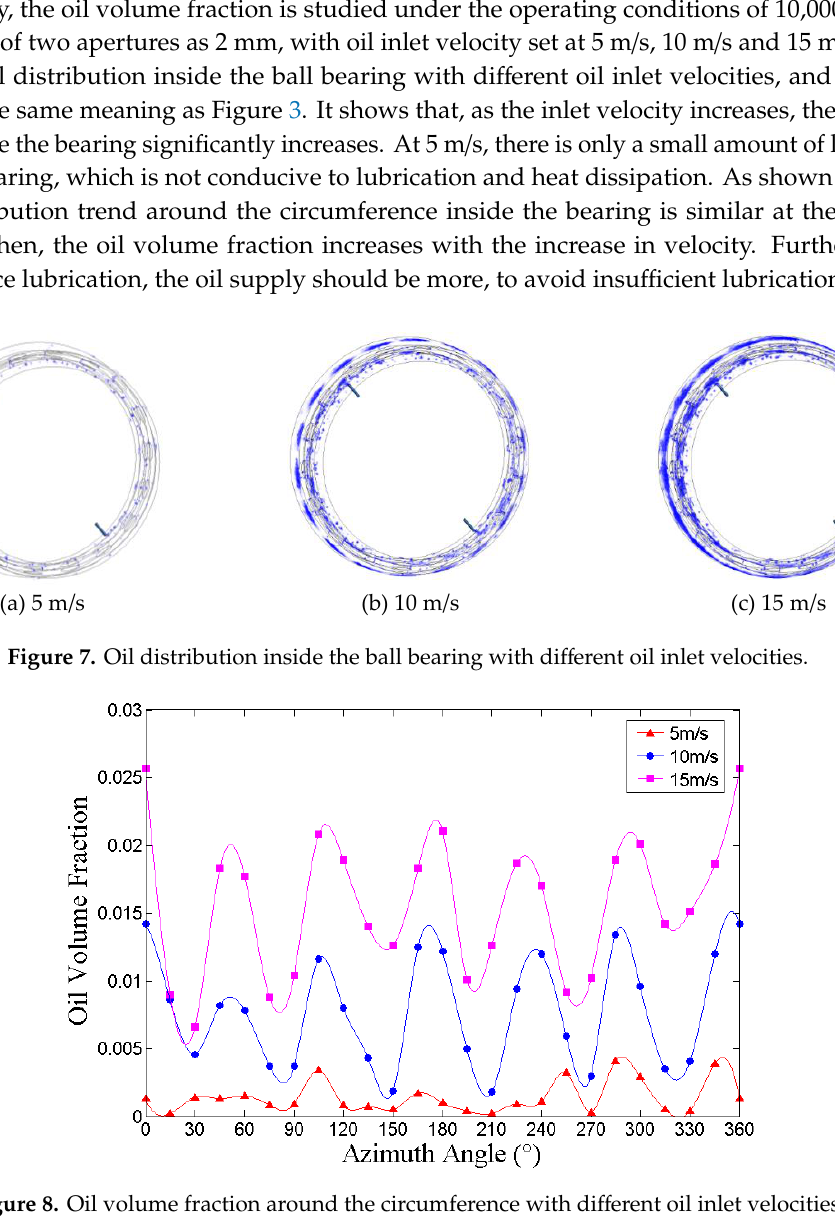
Figure 6. Oil volume fraction around the circumference with different rotational speeds.